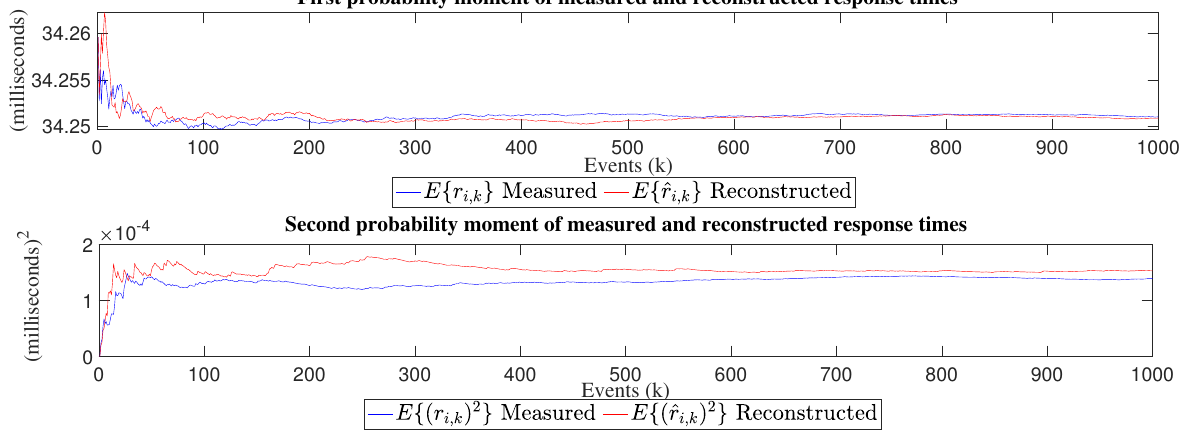
Figure 12. First and second probability moment of reconstructed ˆ r i , k and measured response times r i , k for the 64 × 64 matrix inversion experiment.